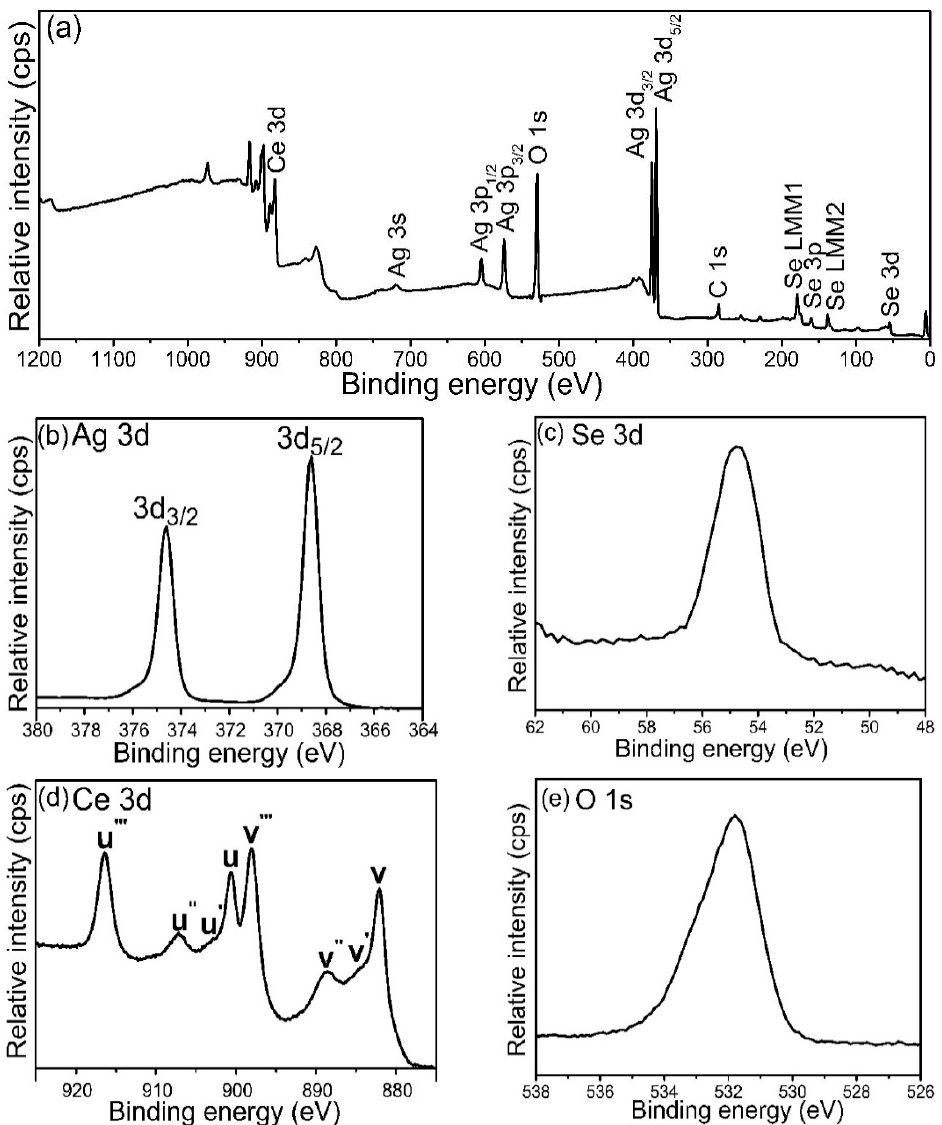
Figure 2. XPS spectra of 10% CeO 2 QDs / Ag 2 Se: ( a ) Survey scan, ( b ) Ag 3d, ( c ) Se 3d, ( d ) Ce 3d, and ( e ) O 1s.